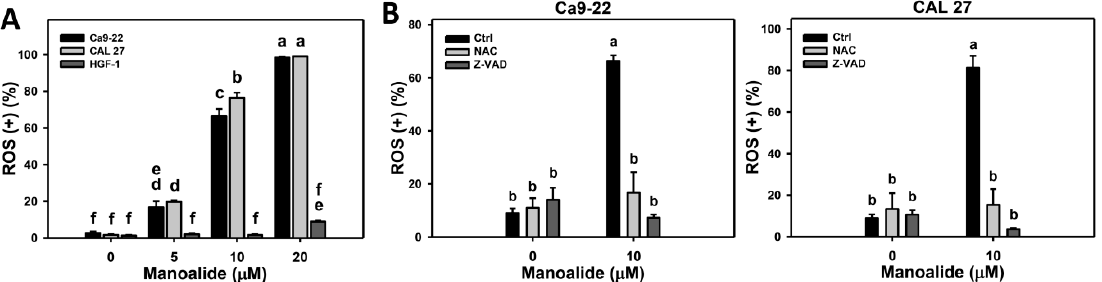
Figure 4. ROS changes in manoalide-treated oral cancer (Ca9-22 and CAL 27) and normal oral (HGF-1) cells. Cells were treated with different concentrations of manoalide for 10 min. ( A ). Statistical results of ROS (+) (%) for manoalide-treated oral cancer and oral normal cells in Figure S7A. ( B ) Statistical results in NAC, Z-VAD, and/or manoalide-treated oral cells in Figure S7B. Cells were pretreated with NAC (8 mM, 1 h) or Z-VAD (100 μ M, 2 h), and posttreated with manoalide (10 μ M, 10 min). Data were analyzed by one-way ANOVA with Tukey HSD Post Hoc Test. Data, means ± SDs ( n = 3). Data showing no overlapping same small letters represent significant differences ( p < 0.05–0.001).